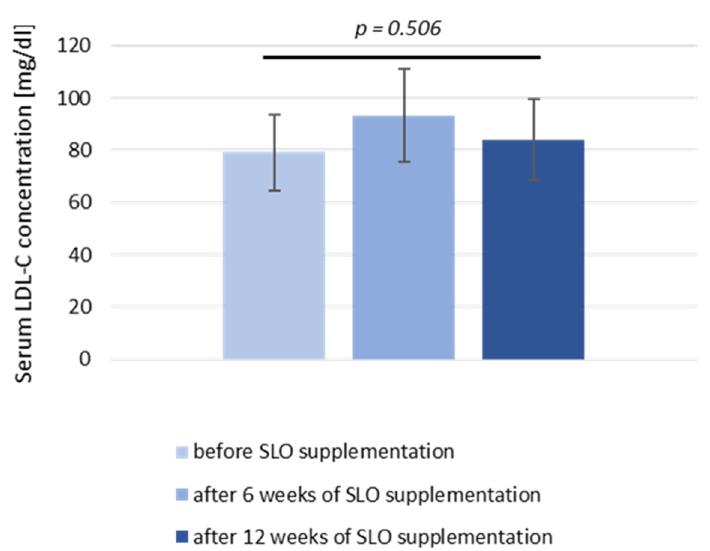
Figure 1. Serum LDL-C level in study participants before and after 6 and 12 weeks of SLO supple- mentation. Data are represented as mean ± SD in n = 6 subjects. Statistical analysis was performed by the Wilcoxon matched-pairs signed rank test.